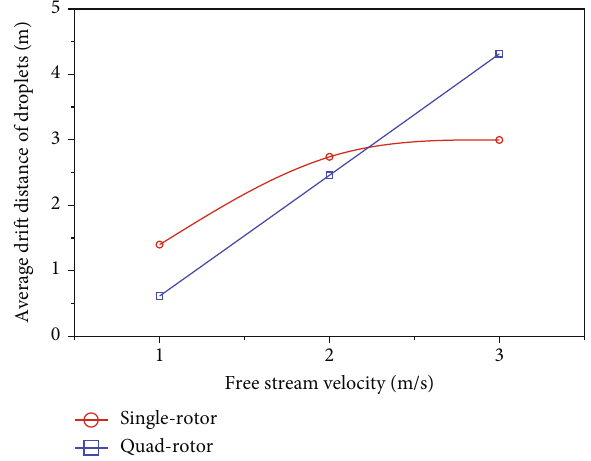
Figure 17: The average drift distance of droplets for di ff erent free stream